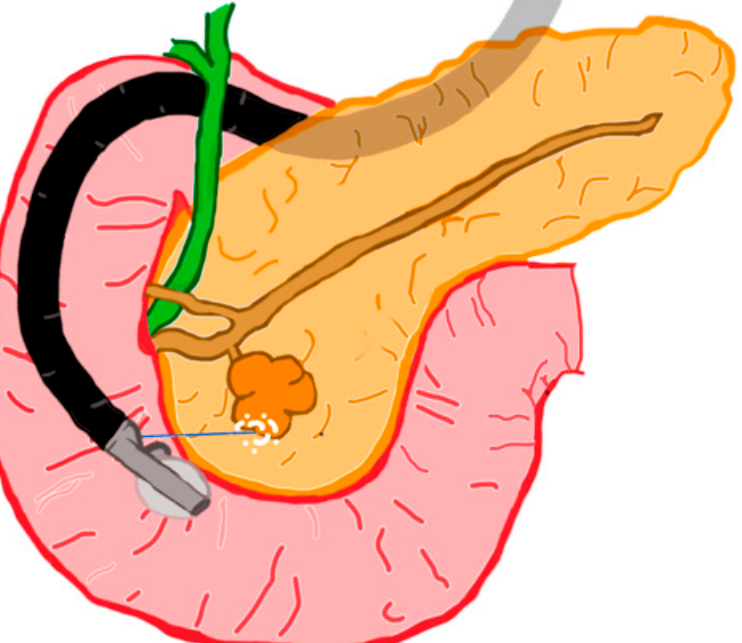
Figure 1 . Schematic of EUS-RFA of a BD-IPMN. Figure 1. Schematic of EUS-RFA of a BD-IPMN.